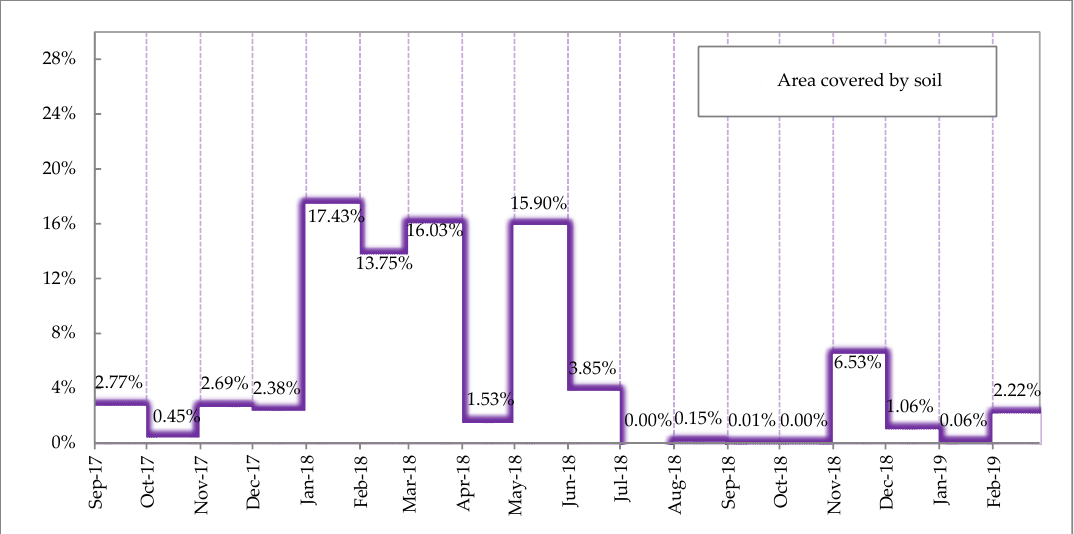
Figure 11. DBSI derived percentage area covered by soil.